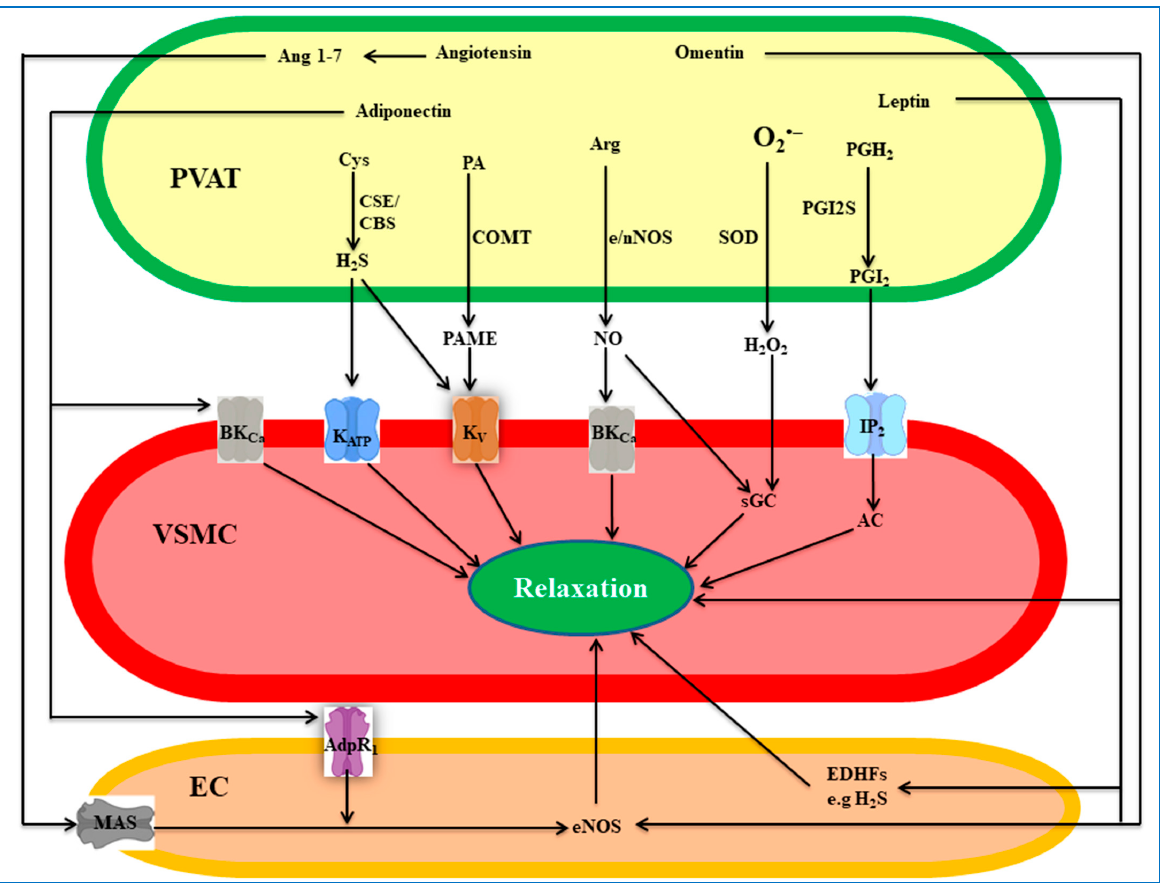
Figure 2. An overview of PVAT-derived anti-contractile factors and the mechanisms underpinning their effects. PVAT synthesizes several factors, including gases (NO and H 2 S), small molecules (H 2 O 2 , PGI 2 , and PAME) and proteins or peptides (adiponectin, angiotensin 1-7, leptin, and omentin). These factors act directly on VSMCs or indirectly on ECs through various mechanisms, such as activating K + channels, soluble guanylyl cyclase, and prostacyclin I 2 receptors or by activating eNOS, ultimately reducing VSMC contraction. EC, endothelial cell; PVAT, perivascular adipose tissue; VSMC, vascular smooth muscle cell; AdpR1, adiponectin receptor 1; BK Ca 1.1, Ca 2+ -activated K + channel; IP2, prostacyclin I 2 receptor; K ATP, ATP-sensitive K + channel; K V , voltage-gated K + channel; AC, adenylyl cyclase; CBS, cystathionine β -synthase; COMT, catechol-O-methyltransferase; CSE, cystathionine γ -lyase; e/nNOS; endothelial or neuronal nitric oxide synthase; PGI2S, PGI 2 synthase; sGC, soluble guanylyl cyclase; SOD, superoxide dismutase; Ang 1-7, angiotensin 1-7; Arg, arginine; Cys, cysteine; EDHF, endothelium-derived hyperpolarizing factor; NO, nitric oxide; PA, palmitic acid; PAME, palmitic acid methyl ester; PGH 2 , prostaglandin H 2 ; PGI 2 , prostacyclin I 2